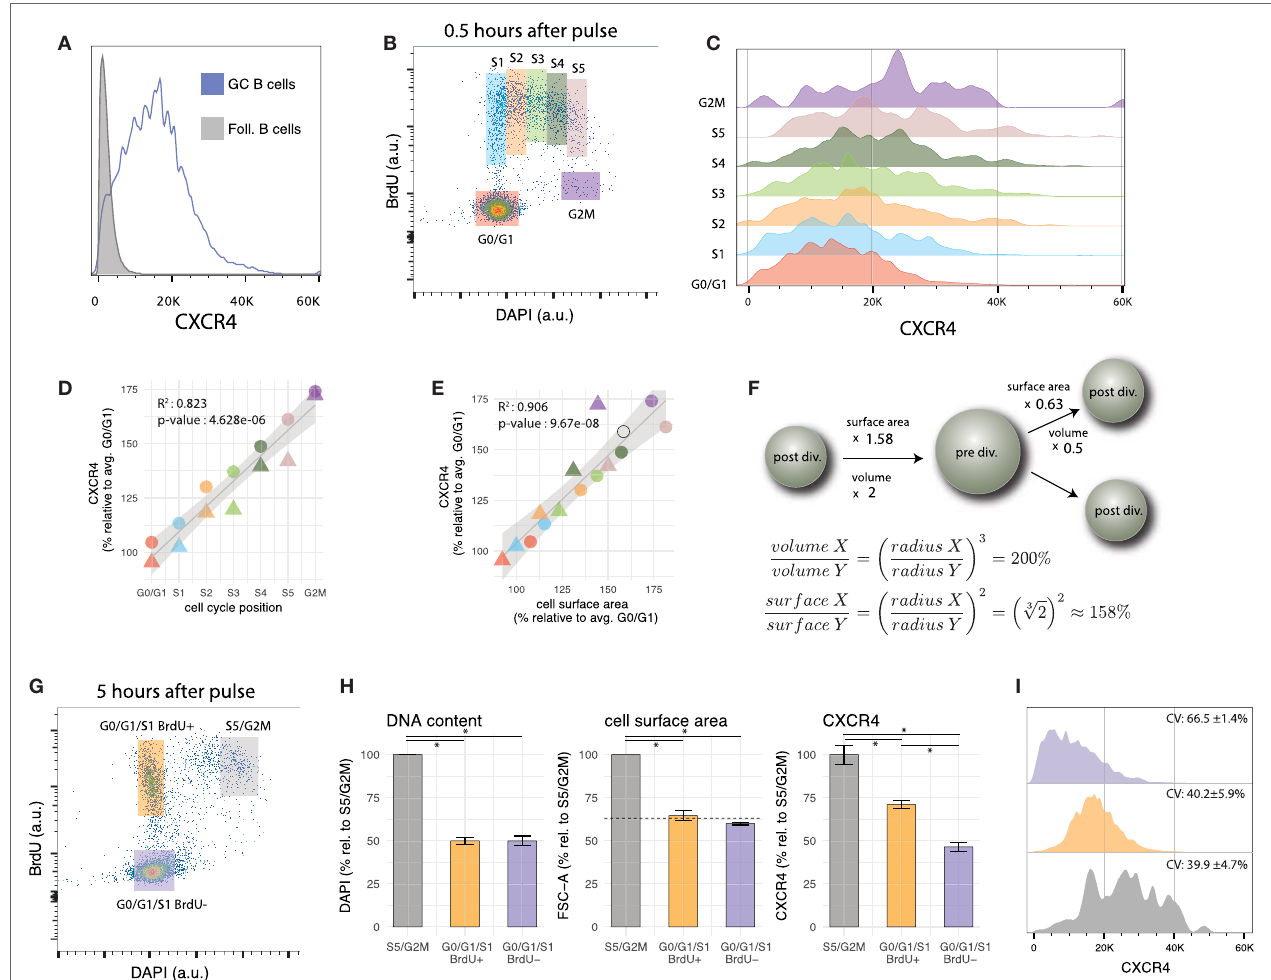
FiGUre 2 | Cell cycle modulates CXCR4 expression in GC B cells. (a) CXCR4 expression in GC B cells is heterogeneous and its distribution is unimodal. CXCR4 expression profile of follicular B cells is shown as a negative reference. (B) Gates used to group GC B cells according to cell cycle position. (C) CXCR4 expression profile of GC B cells shifts to higher values as cells progress in cell cycle. (d) Average CXCR4 expression level increases with cell cycle position. Color and shape of the points indicate gate and mouse, respectively. (e) Average CXCR4 expression level increases linearly with cell surface area (as measured by forward scatter). The open circle indicates the relative increase in cell surface area expected from a doubling in volume of a perfect sphere. (F) Relative increase in surface area of a perfect sphere as it doubles/halves its volume, derived using calculus. (G) Representative example of bi-variate scatter plot of DAPI (DNA content) versus BrdU 5 h after BrdU pulse. Recently divided GC B cells are in G0/G1/S1 BrdU + gate (orange), while cells that were in S phase during the pulse, and are about to divide are in the S5/G2M gate (gray). Relatively aged GC B cells that have completed their last division cycle more than 5 h ago (and rare cells that were in G2M phase during the pulse) are in the G0/G1/S1 BrdU − gate (violet). (H) DNA content (DAPI), cell surface area (FSC), and CXCR4 for the gates defined in panel (G) . The dashed line indicates the reduction in surface area of a perfect sphere that halves its volume. (i) CXCR4 expression profiles of cells in the S5/G2M, G0/G1/S1 BrdU + , G0/G1/S1 BrdU − gates. As cells divide, they pass from S5/G2M to the G0/G1 BrdU + gate, resulting in a reduction of average CXCR4 expression by a factor of 0.71 ± 0.01 (H) , but no change in CV. The population with the highest CV (66.5 ± 1.4%) are the cells in the G0/G1/S1 BrdU − gate, having a low mean but a relatively large spread toward higher